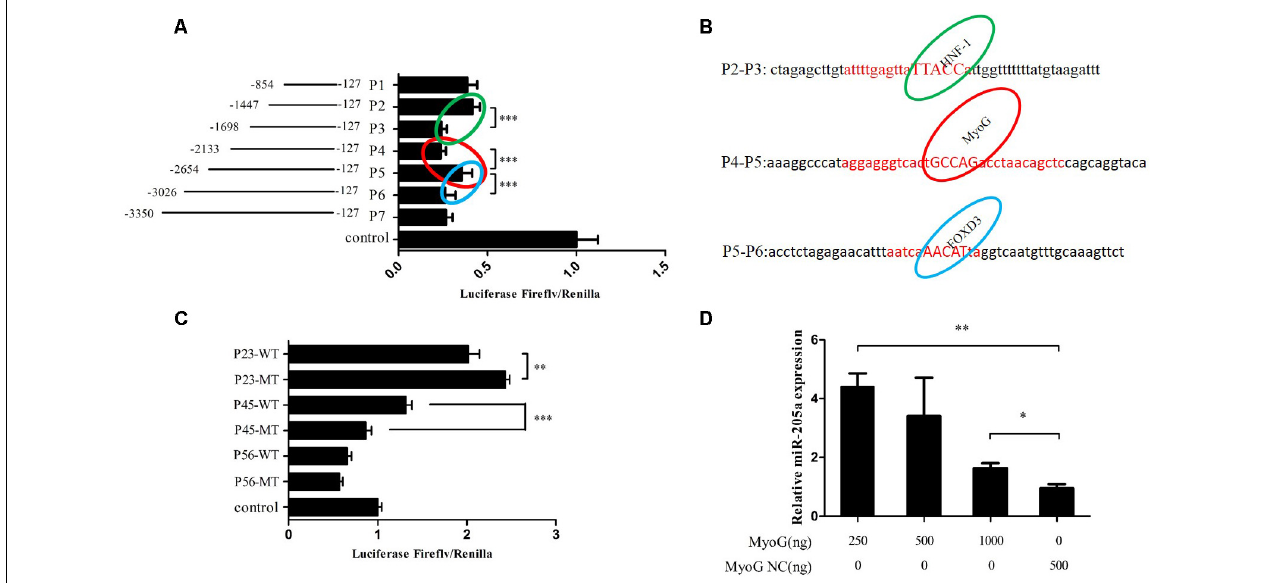
FIGURE 6 | MyoG could regulate the expression of miR-205a. (A) Dual-luciferase reporter assay using the clones’ upstream regions of the chicken pre-miR-205a. (B) Three possible transcription factors predicted on the Gene-regulation. Their binding sites are highlighted in the red capital. (C) Luciferase assay was conducted by co-transfecting the vectors containing potential promoter region or mutant transcription factors binding sites with TK-Renilla plasmid. (D) Overexpression of MyoG can promote miR-205a expression. Results are shown as mean ± SEM and the data are representative of at least three independent assays. Independent sample t -test was used to analyze the statistical differences between groups. ∗ P < 0.05; ∗∗ P < 0.01; ∗∗∗ P < 0.001.